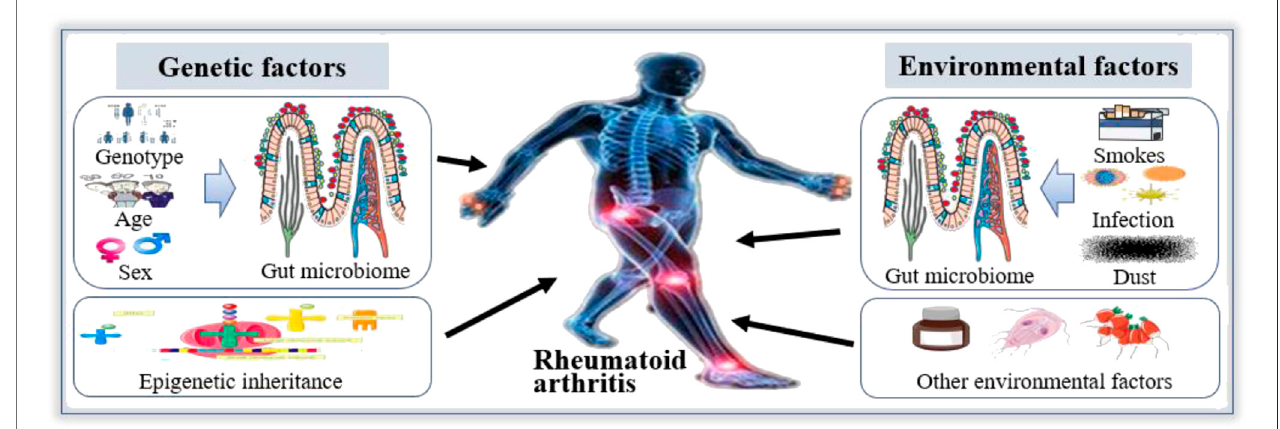
FIGURE1| GutmicrobiomeintheetiologyofRheumatoidarthritis(RA).TheetiologyofRAismainlyrelatedtoenvironmentalfactorsandgeneticfactors.Amongthe environmental factors, smoking, infection and dust can affect the structure of gut microbiome to participate in the occurrence and development of RA. Among genetic factors, the composition of gut microbiome is associated with genotype and sex, which is linked to the occurrence and development of RA. Therefore, gut microbiome play an important role in the etiology of RA.